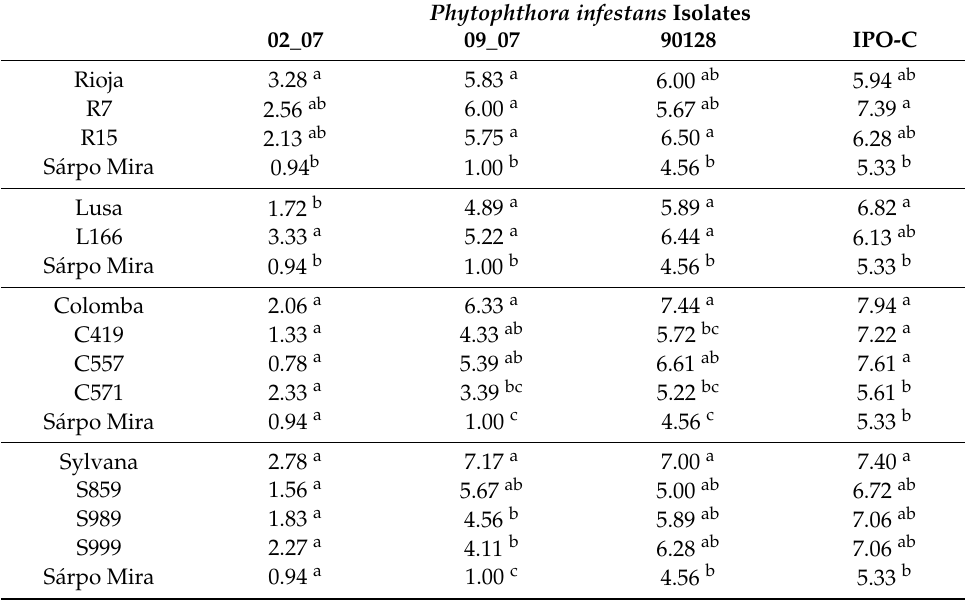
Table 1. Mean disease (MD) scores for progeny R8 genotypes divided into four cross groups, after infection with each Phytophthora infestans isolate (02_07, 09_07, 90128, and IPO-C), at 8 dpi. Each cross group consists of MD scores for the progeny R8 genotypes, the corresponding susceptible parental cultivar, and the resistant cultivar S á rpo Mira. ANOVA was performed within each cross group, to compare the progeny R8 genotypes with the parental cultivars for each P. infestans isolate, and Tukey’s range test was used for post-hoc analysis. Same letters within the cross group for individual P. infestans isolate indicate no statistical